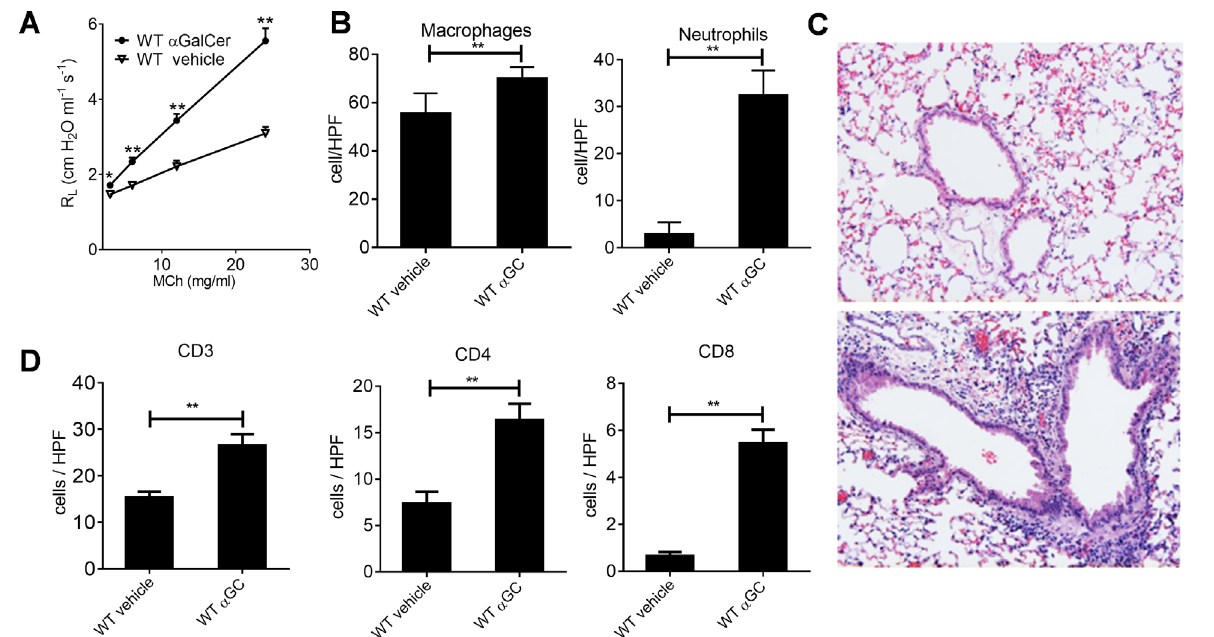
Fig 1. A-GalCer induces AHR, neutrophil influx and inflammation in lungs of WT mice. A. Direct lung resistance (R L ) was measured in WT mice after 24 hours after i.n. administration of vehicle or α -GalCer ( α GC) using the ELAN system. B. Macrophage and neutrophil cell distributions were calculated (20x magnification) from cytospinned and MGG-stained BALF samples. C. Vehicle (upper figure) and α -GalCer — treated (lower figure), paraffin embedded lung sections were H&E stained, and D. Corresponding cryosections were stained with anti-CD3, anti-CD4 or with anti-CD8 mAbs to identify the number and localization of different T cell subsets. * P, 0.05; ** P, 0.01; *** P, 0.001. n = 8 mice/group.